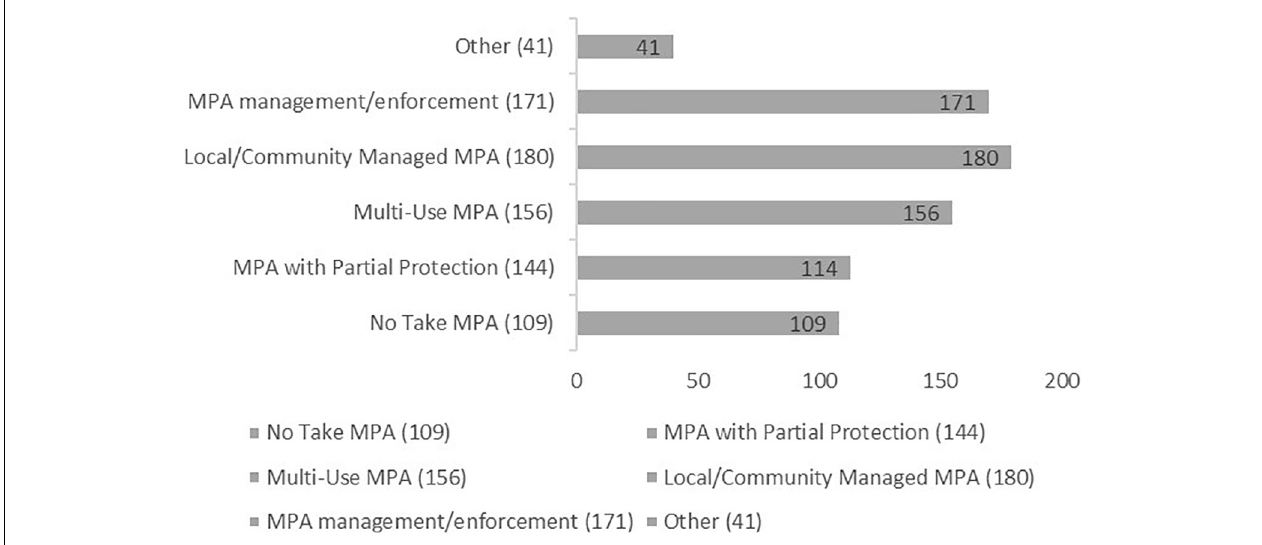
FIGURE 3 | Marine protected area commitments. Voluntary commitments made with regards to sustainable development goal (SDG) 14.5 (marine protected area goal). Chart represents proportion chosen within the different category commitments. Data from https://oceanconference.un.org/commitments/ as of September